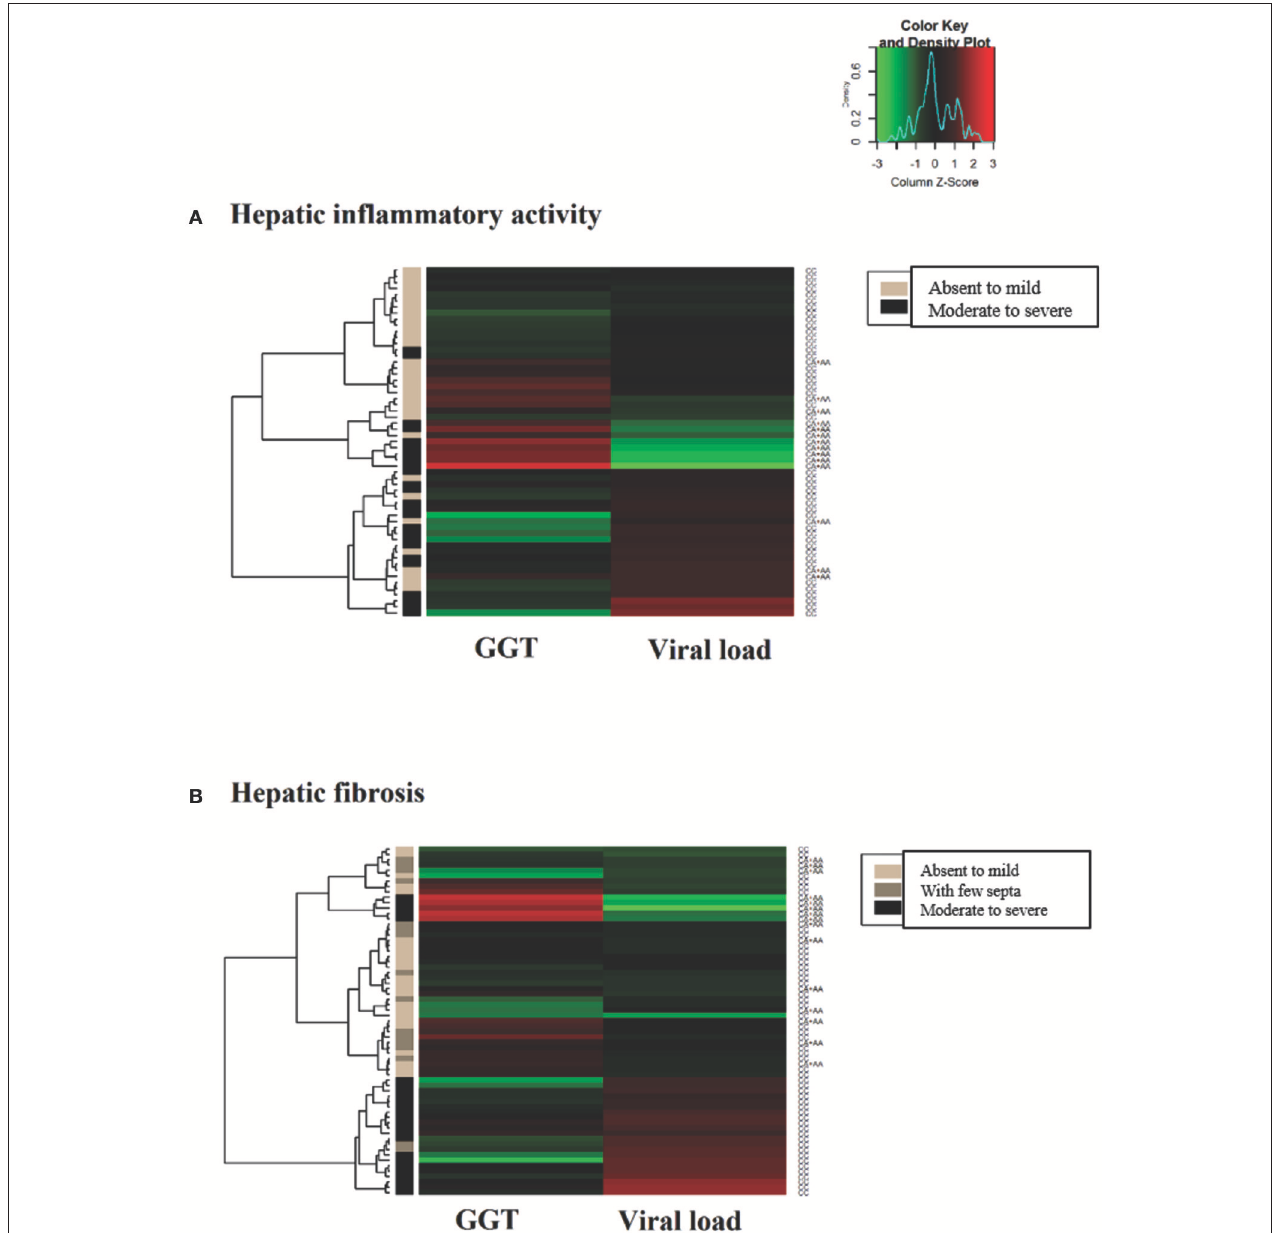
FIGURE 4 | Heatmap matrix analysis of liver function profiles according to the histopathological characteristics and − 3279C > A polymorphism genotypes in CHC patients. (A) Inflammatory activity and high viral loads clustered with low to intermediate GGT levels in a group composed predominantly of individuals with the CC genotype and with moderate to severe inflammatory activity. Sub-cluster groups with high GGT levels and low viral loads in individuals with the * A allele in homozygous or heterozygous individuals with moderate to severe inflammatory activity. (B) In patients with liver fibrosis, a cluster was formed with high viral loads and low to intermediate GGT levels predominantly in individuals with the CC genotype and advanced liver fibrosis to